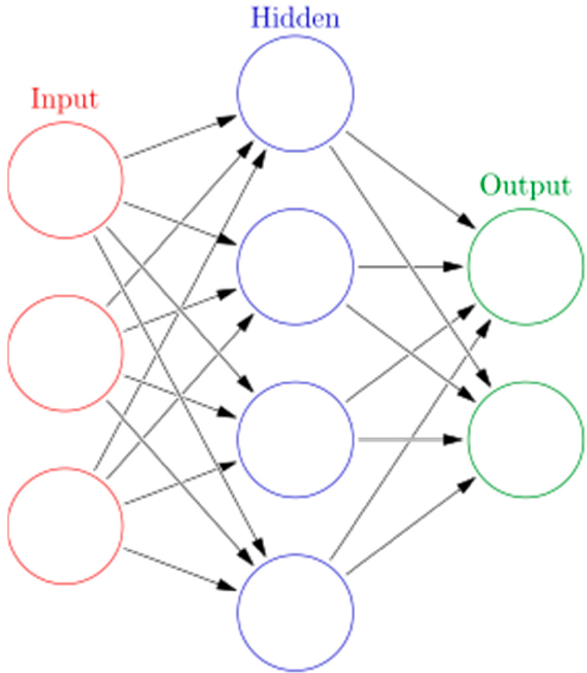
Figure 5. A very simple artificial neural network